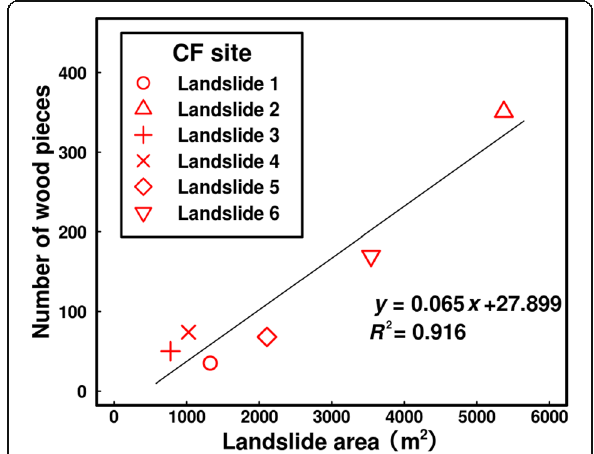
Fig. 9 Comparison between landslide area and the number of